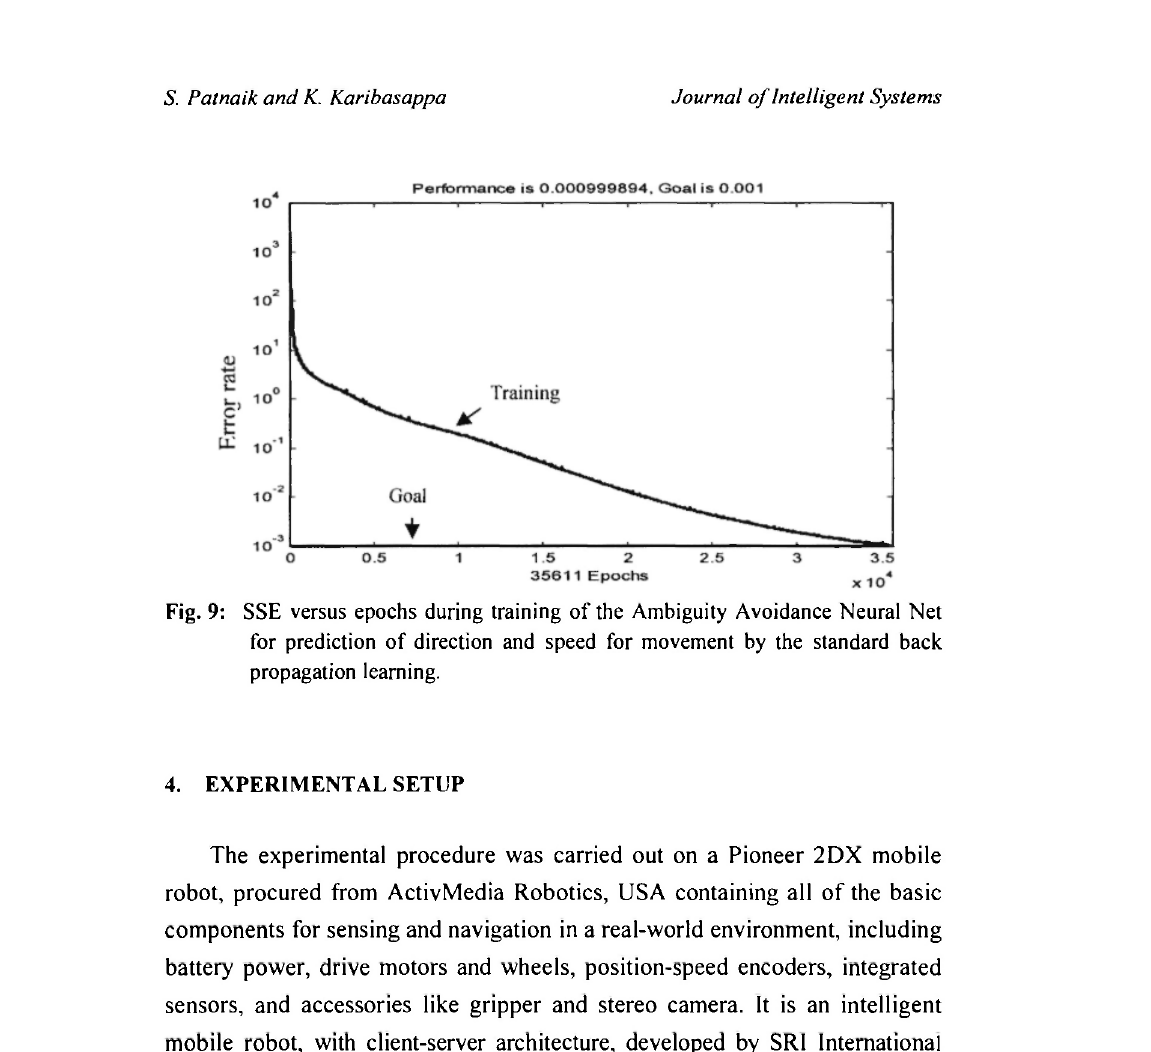
Fig. 9: SSE versus epochs during training of the Ambiguity Avoidance Neural Net for prediction of direction and speed for movement by the standard back propagation